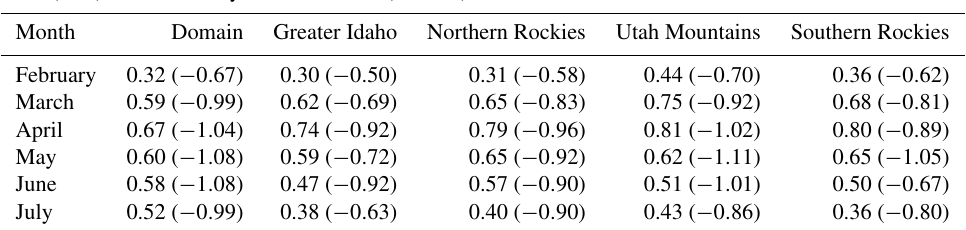
Table 4. Same as in Table 3 but for the TOA RE.